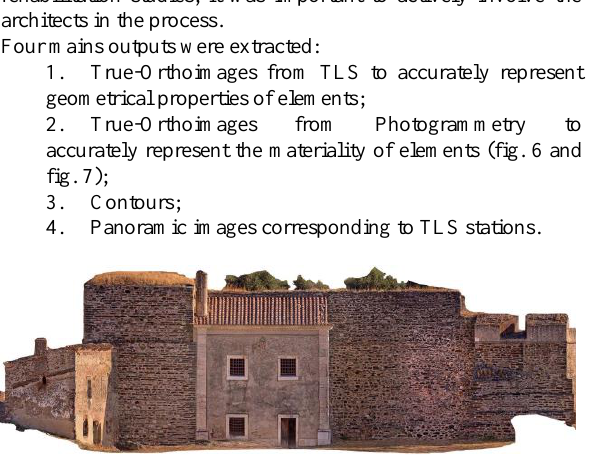
Figure 6. Sample of True-Orthoimage based in aerial photogrammetry high-res